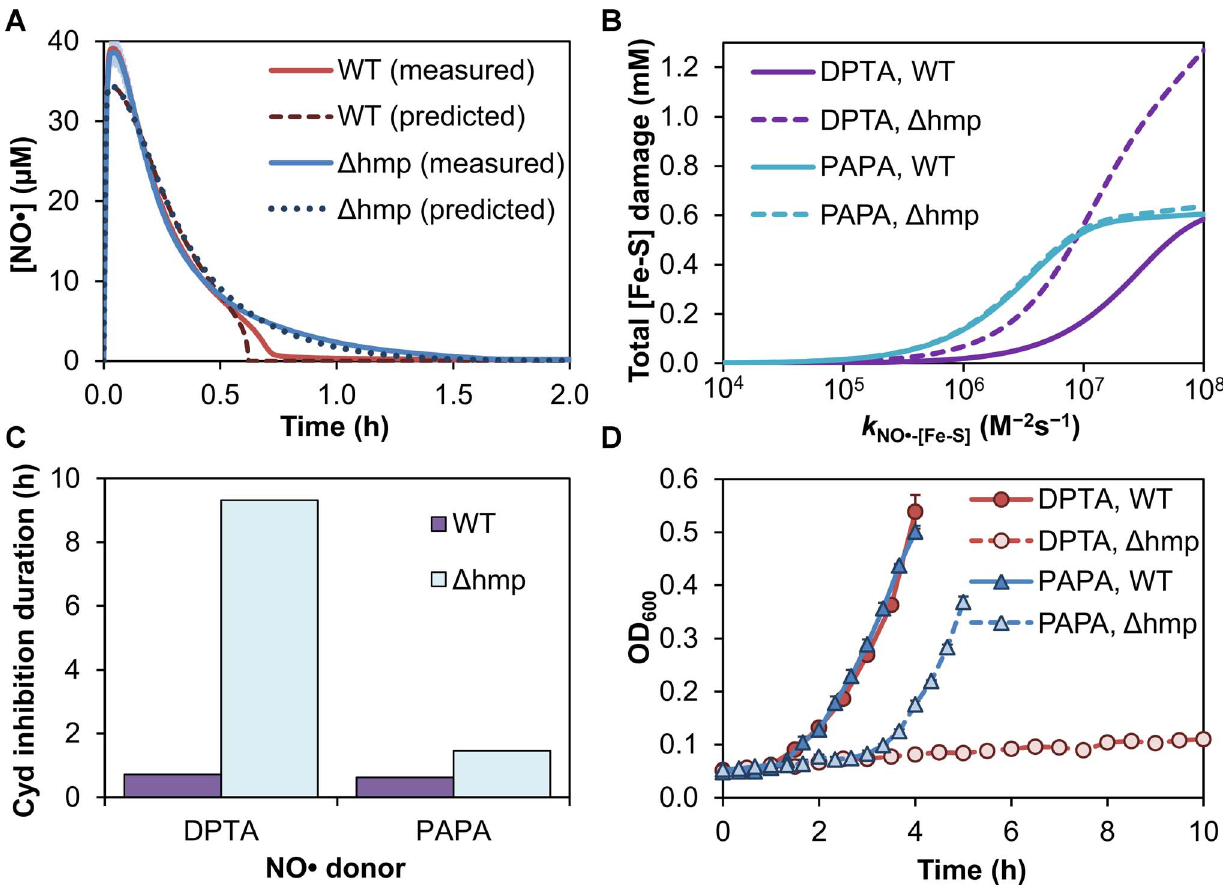
Figure 6. The utility of Hmp for NO N consumption and tolerance decreases with increased NO N delivery rate. (A) Experimentally measured NO N concentration profiles following addition of 0.5 mM PAPA to a culture of wild-type (solid red line) or D hmp (solid blue line) E. coli at an OD 600 of 0.05. Lines depict the mean of three independent experiments, and error bars (light red and light blue for wild-type and D hmp , respectively) represent the standard error of the mean. Also shown are the corresponding model-predicted NO N concentration profiles for wild-type (dark red dashed line) or D hmp (dark blue dotted line) cultures. (B) . Predicted cumulative concentration (per unit cellular volume) of [2Fe-2S] and [4Fe-4S] clusters damaged following DPTA (purple) or PAPA (teal) treatment of wild-type (solid lines) and D hmp cultures (dashed lines) is plotted as a function of the model parameter governing the rate of [Fe-S] nitrosylation by NO N ( k NO N -[Fe-S] ). (C) Predicted durations of cytochrome bd (Cyd) inhibition by NO N , defined as the time required for the percentage of NO N -bound Cyd to drop below 50% of the total Cyd concentration. (D) Experimentally measured growth curves (quantified by OD 600 ) for wild-type and D hmp cultures following treatment with 0.5 mM of DPTA or PAPA demonstrate more comparable duration of bacteriostasis between wild-type and D hmp for treatment with PAPA than DPTA. Due to the faster NO N delivery kinetics associated with PAPA, OD 600 readings were taken more frequently (20 min intervals) than with DPTA (30 min intervals). After addition of DPTA to D hmp cells, growth resumption was not observed within the 10 h timeframe of the